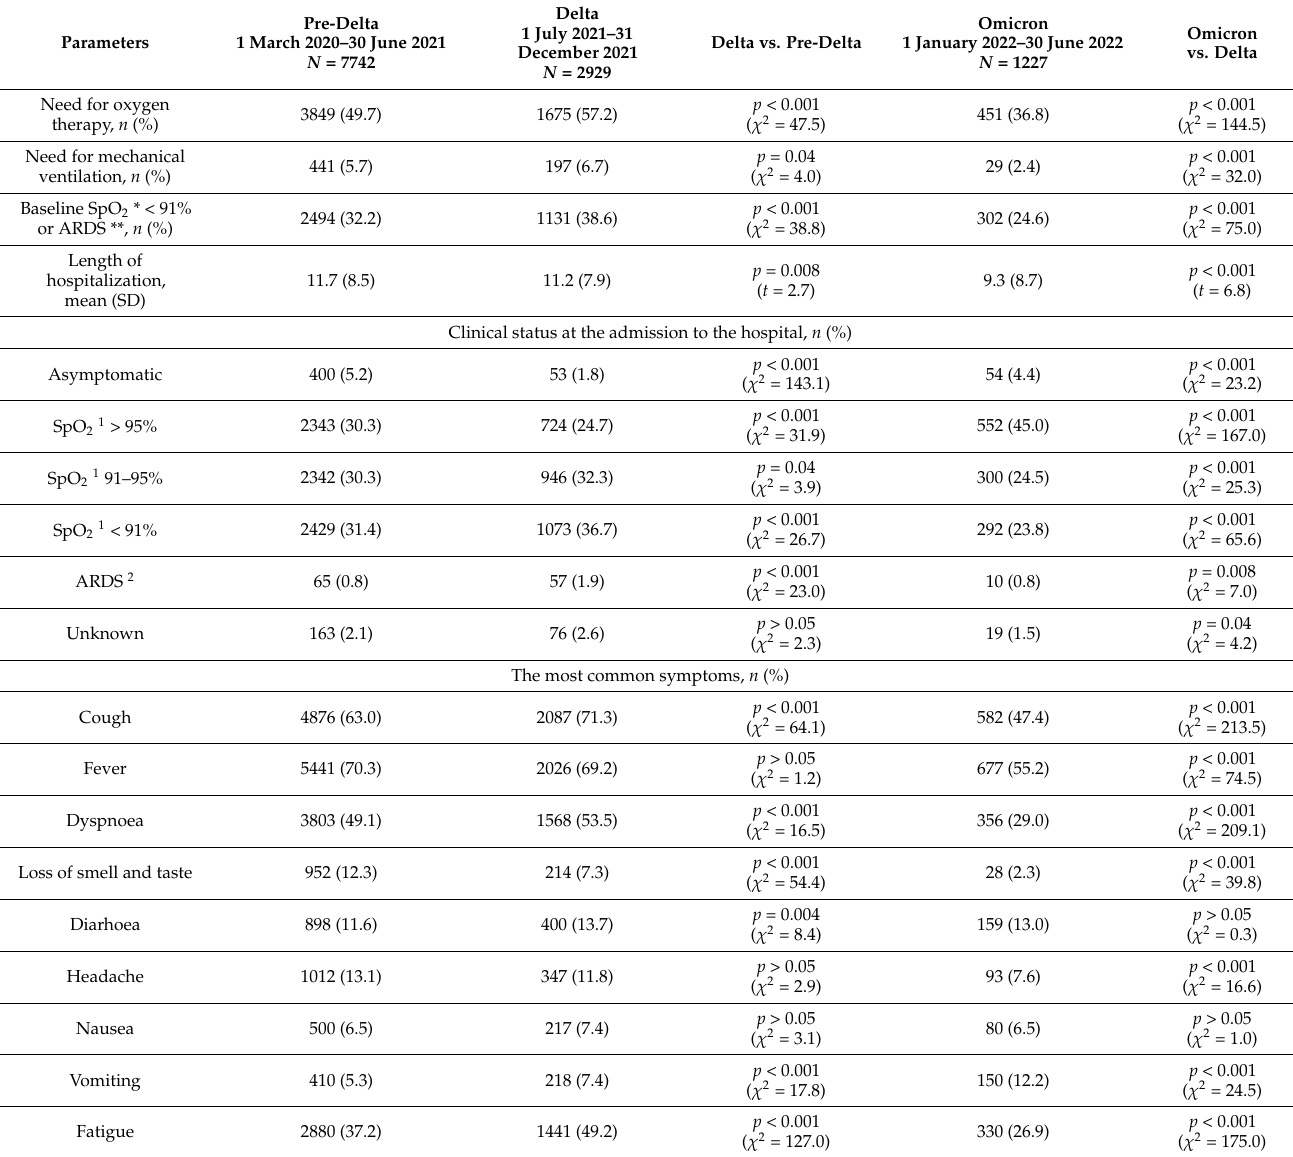
Table 2. Characteristics of the course of the disease during periods with the dominance of particular SARS-CoV-2